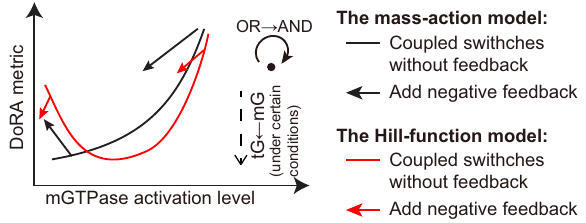
Fig. 6 Summary of the effects of kinetic details on the DoRA. DoRA metric is closely related to mGTPase activation level, and this relation depends on reaction kinetics, the existence of negative feedbacks (straight solid arrow), cascade length (straight dashed arrow), and logics for negative feedback (curved solid